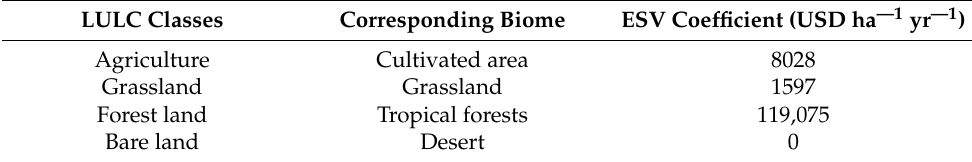
Table 3. ESV coefficients, accompanying equivalent biomes, and LULC classes.